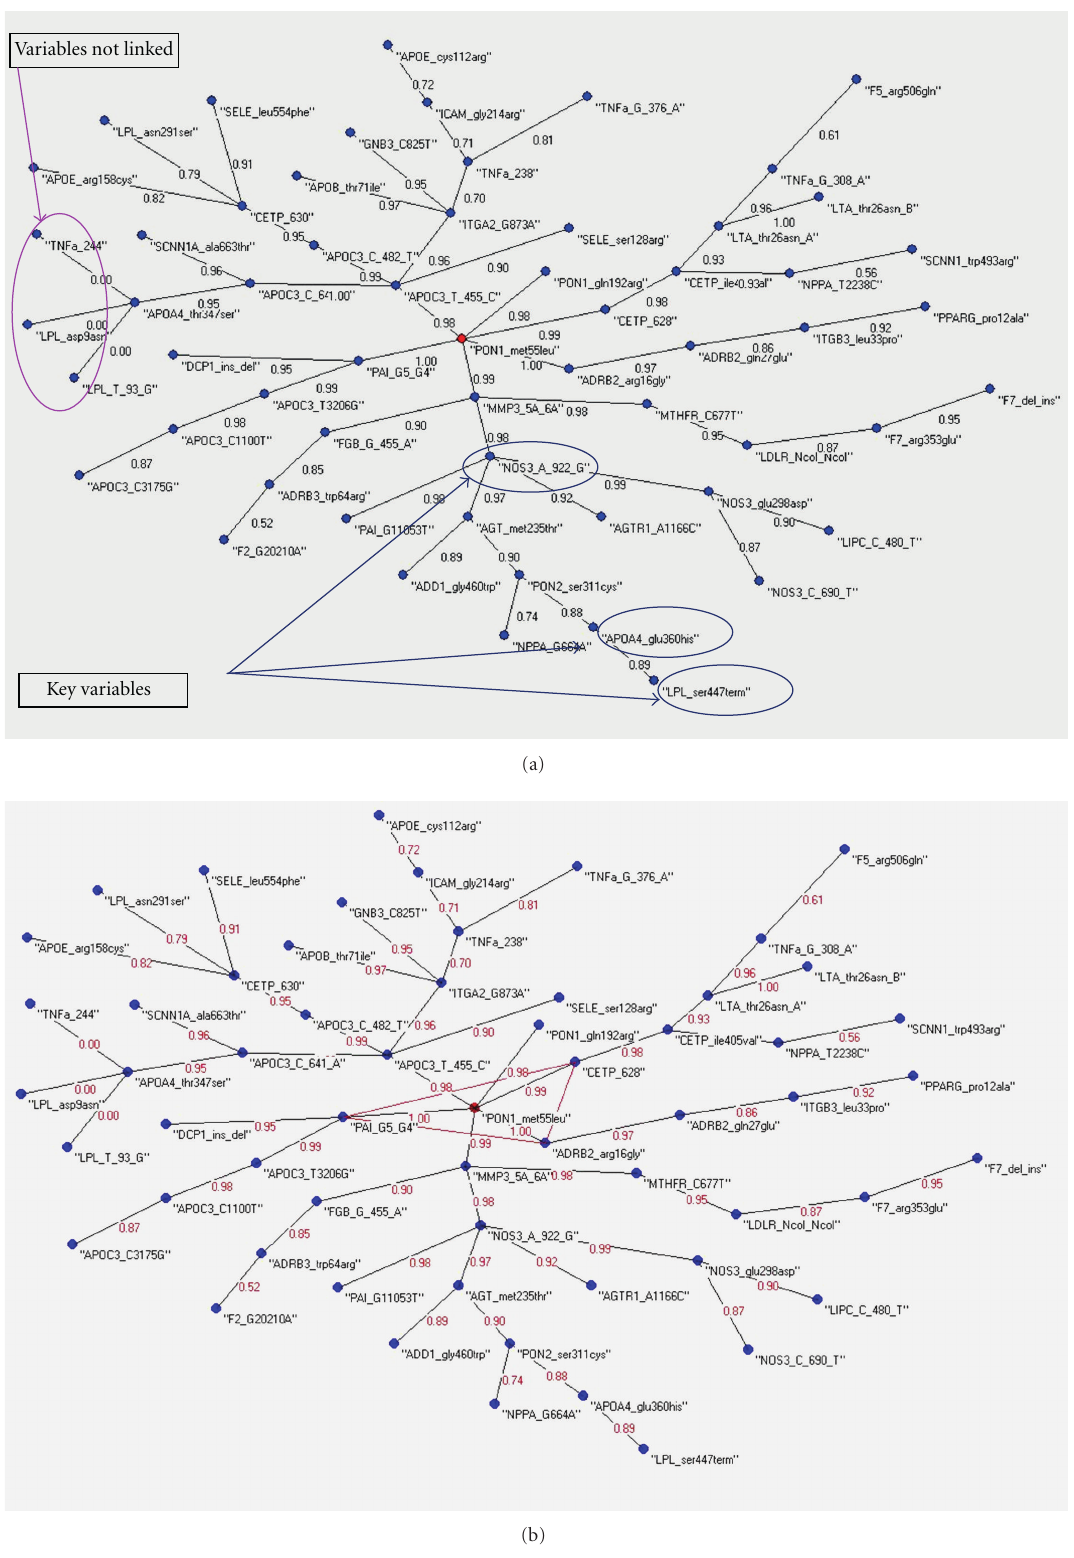
Figure 2: (a) The MST of the cases databest. Into the blue circles the key variables of the graph. (b) The MST of the controls databest. Into the red circles the key variables of the